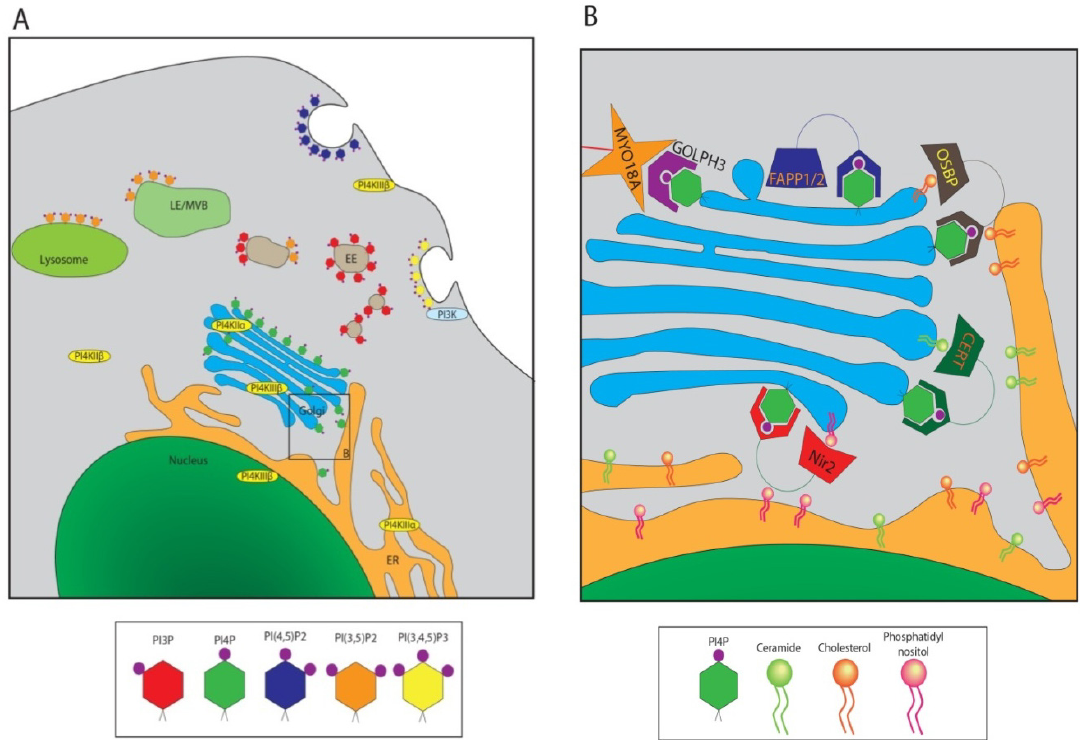
Figure 2. Cellular Localizations of Various Phosphoinositides. ( A ) Diagram of a typical cell, highlighting the locations of various PIPs in different cellular membranes. EE: Early endosome; LE/MVB: Late endosome/multi-vesicular body. Some PI kinases are also given in their cellular locations. PI4Ks are in yellow ovals, PI3K in cyan; ( B ) Close-up of panel B in Figure 2A. PI4P binding proteins at the Golgi/TGN are localized, as well as the lipids or other proteins to which they bind. Lipid transfer proteins (LTPs) Nir2, CERT, and OSBP are shown shuttling their preferred lipid cargo from the ER; PI (pink), ceramide (green), and cholesterol (orange),